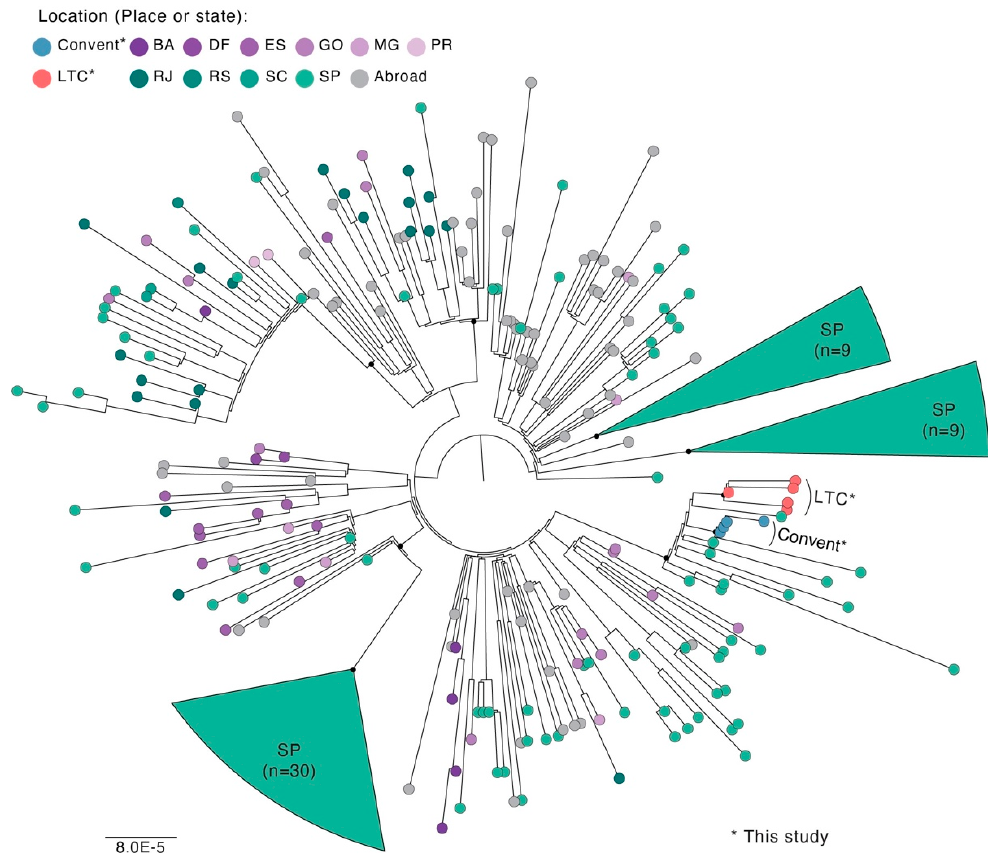
Figure 3. Maximum-likelihood tree ( n = 264) was estimated using IQ-tree version 1.6.12 [27] and constructed using an alignment of the near-complete genome (untranslated regions were removed) and using a GTR + F + I substitution model [28] with 1000 ultrafast bootstrap replicates. The scale bar indicates the evolutionary distance in numbers of substitutions per nucleotide site. The color on terminal branches indicates the place (LTC facility, n = 5 and convent, n = 4) or Brazilian state reported, as indicated in the legend. The sequences are available on GISAID, accession numbers: